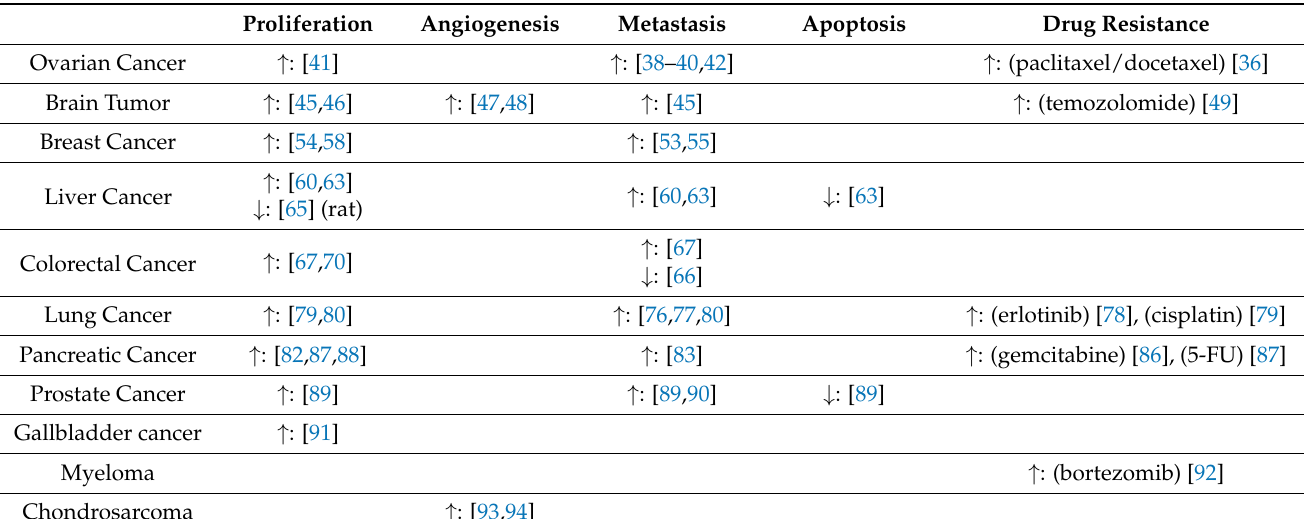
Table 2. Main effects of leptin/leptin receptor in different cancer